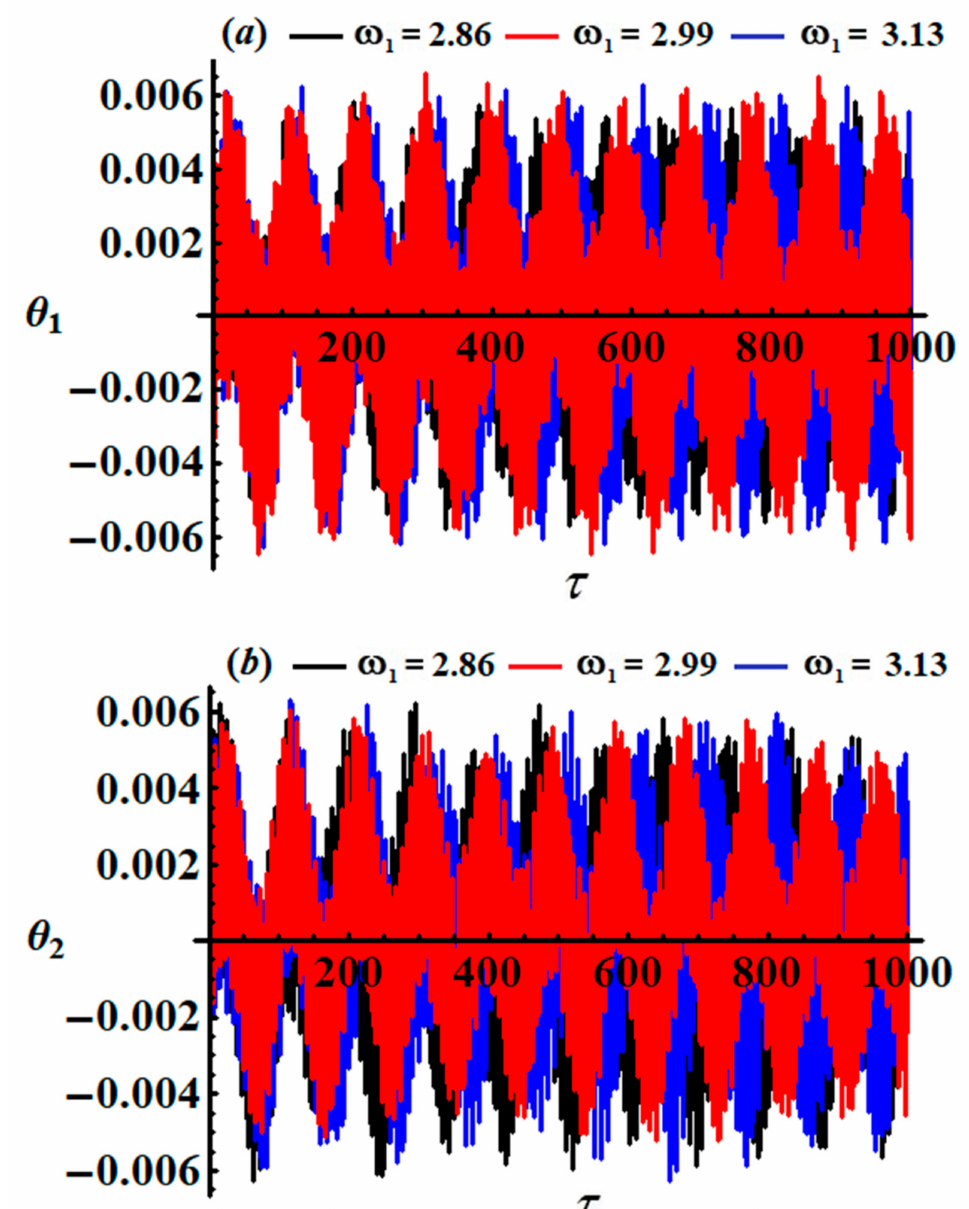
Figure 4. The time histories of the solutions at ω 1 = ( 2.86,2.99,3.13 ) : ( a ) for θ 1 , ( b ) for θ 2